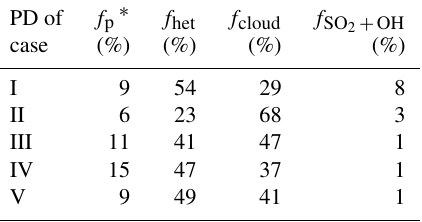
Table 2. Estimated fractional contribution of different sulfate pro- duction pathways during Beijing